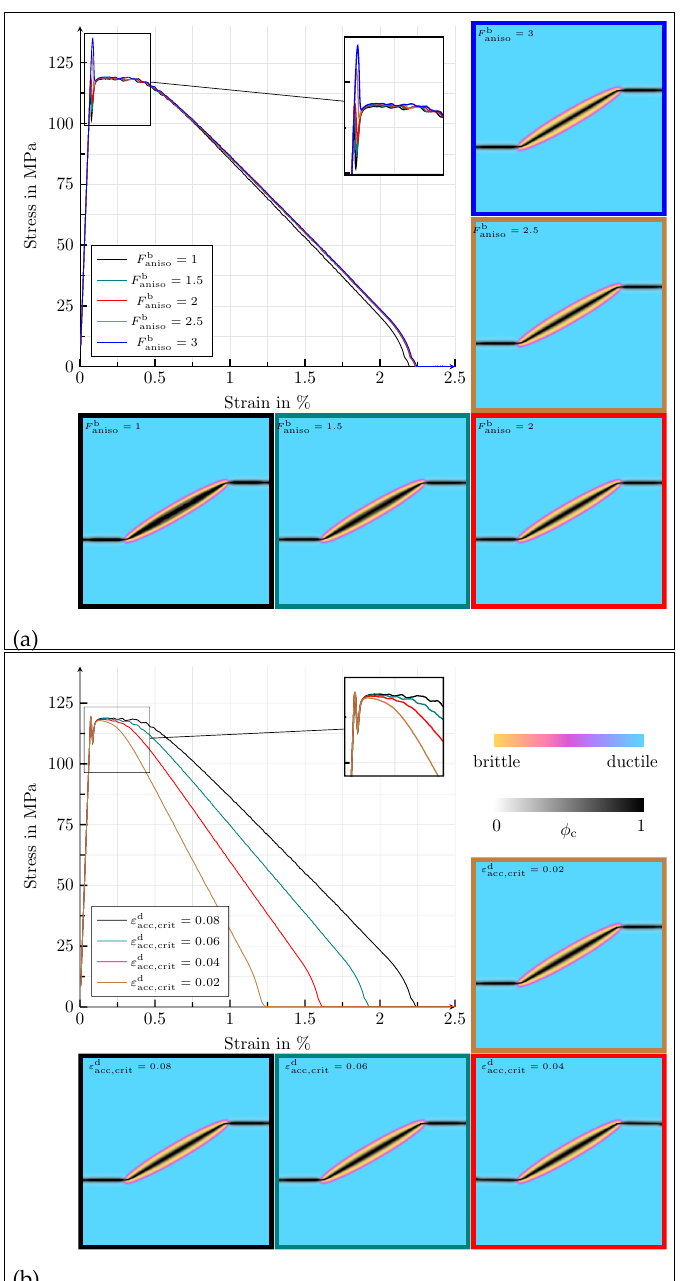
Figure 8. ( a ) Homogenised macroscopic stress–strain responses in the case of uniaxial tension for = different values of F b 1,1.5,2,2.5,3 , for the simulation setup with a single elliptic, transversely aniso { } isotropic, brittle inclusion in a ductile matrix. The contour plots of the crack phase φ c at fracture, overlaying the solid phases, for the different values of F b are given below and beneath the stress– aniso strain diagram. ( b ) Homogenised macroscopic stress–strain responses in the case of uniaxial tension = for different values of ε d 0.08,0.06,0.04,0.02 , for the simulation setup with a single elliptic, acc,crit { } transversely isotropic, brittle inclusion in a ductile matrix. The contour plots of the crack phase φ c at fracture, overlaying the solid phases, for the different values of ε d are given below and beneath acc,crit the stress–strain